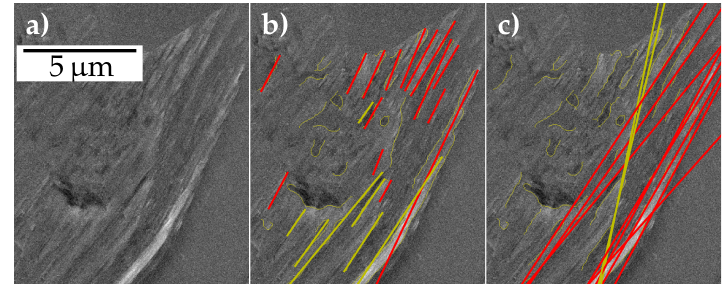
Figure 9. Images comparing STO results from ICEO and CHL. ( a ) extrusion image and ( b , c ) slip trace orientation clusters found from using ICEO and CHL,